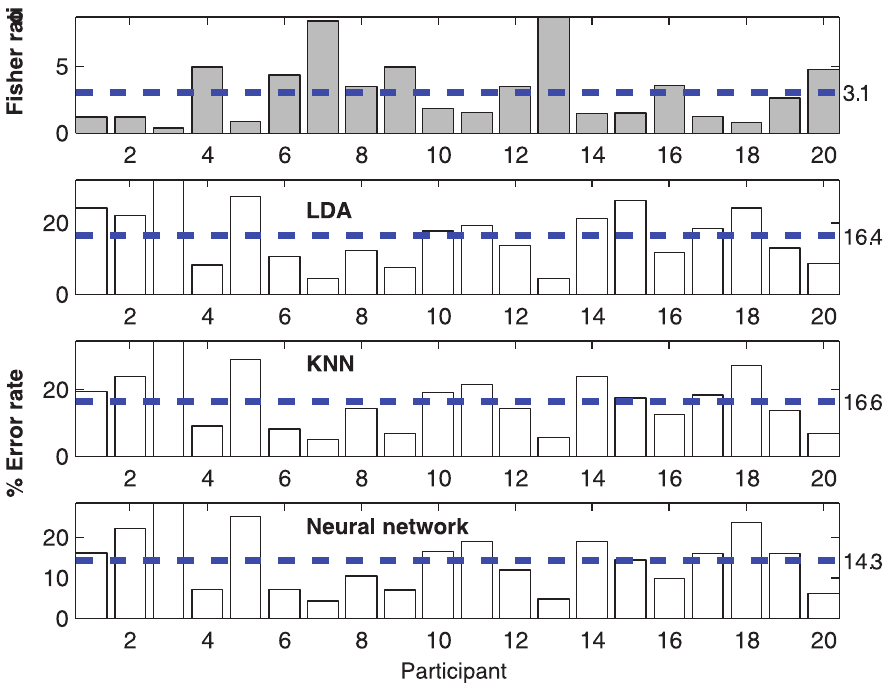
Figure 6. Separability of intra- and inter-participant NCC values. Separability measured by Fisher’s ratio (top graph) and classification error rates by LDA, KNN and NN classifiers (bottom three graphs respectively). The dashed line represents the average value of each method.